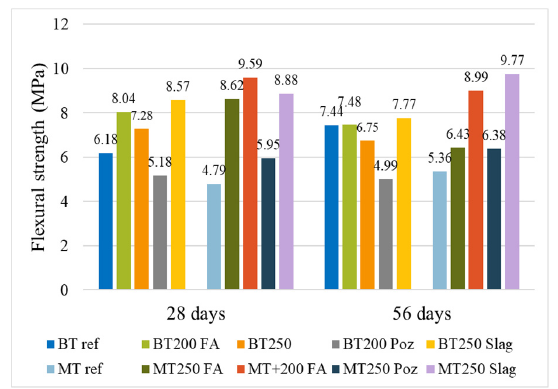
Figure 1. Flexural strength at 28 and 56 days. Figure 2. Compressive strength at 28 and 56